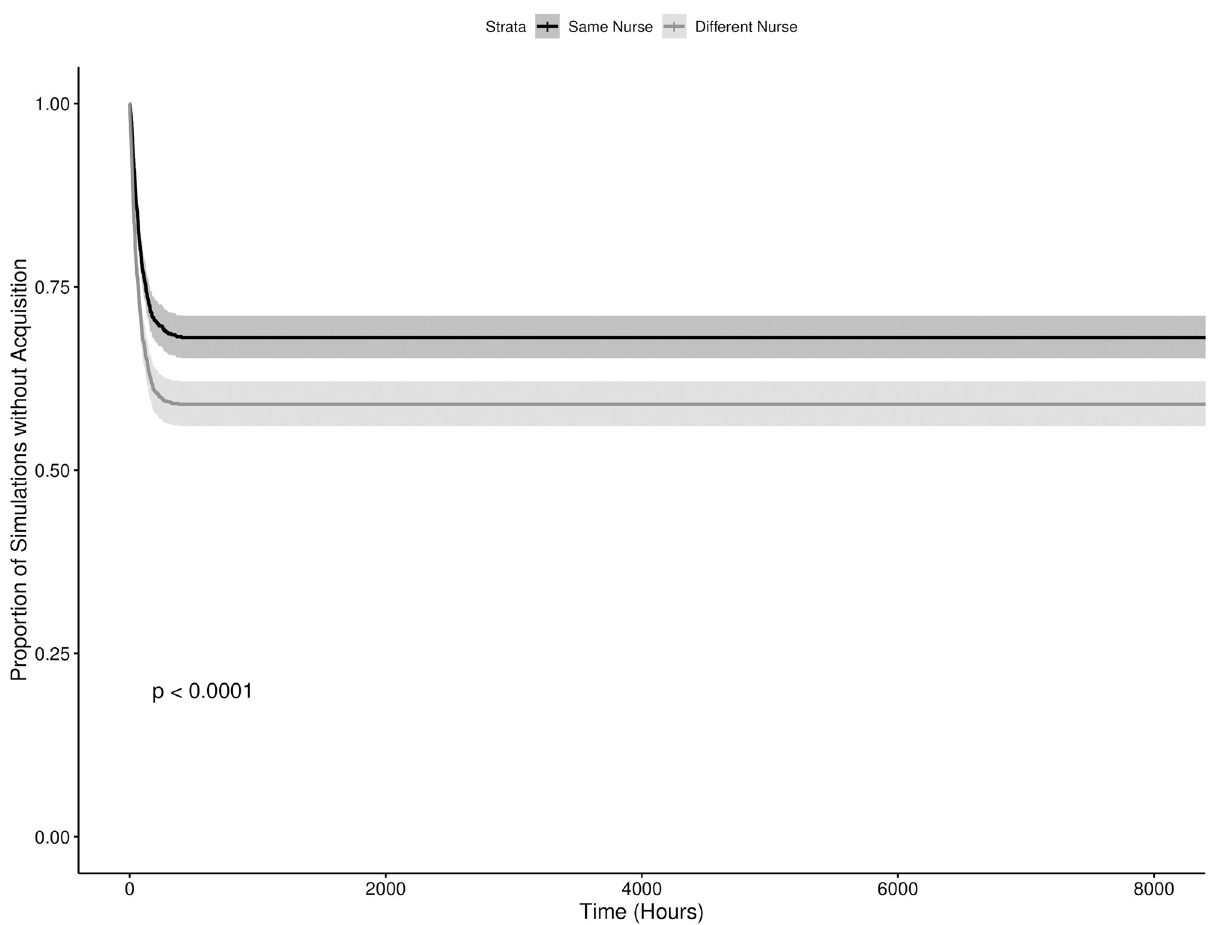
Fig 5. Time to first MRSA acquisition in an ICU meta-population model with no colonized admissions. The dark and light grey lines indicate starting conditions where two initially colonized patients are cared for by the same and different nurses respectively, with the shaded regions representing the corresponding 95% confidence